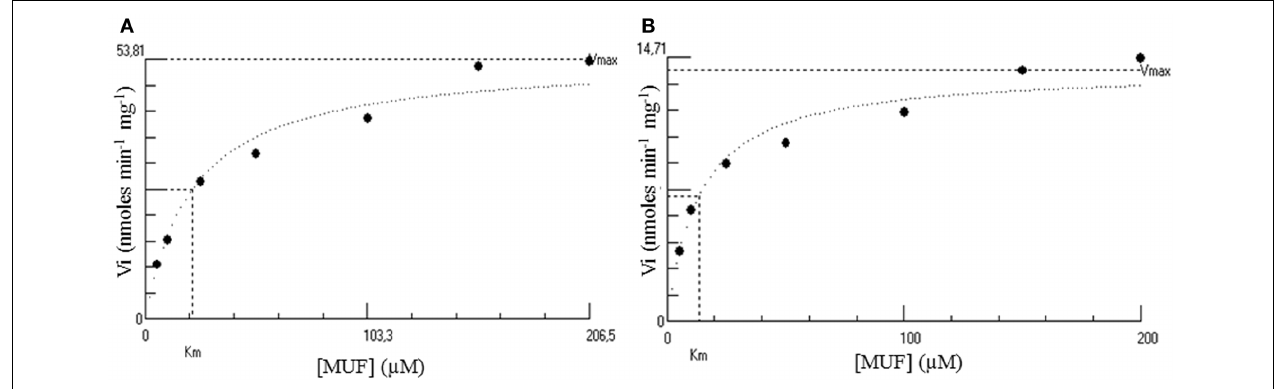
from 5.2 to 206.5 μ M. These plots have been performed using the software Hyper32 version 1.0.0. (http://homepage . ntlworld . com/john . easterby). They are representative of experiments performed in